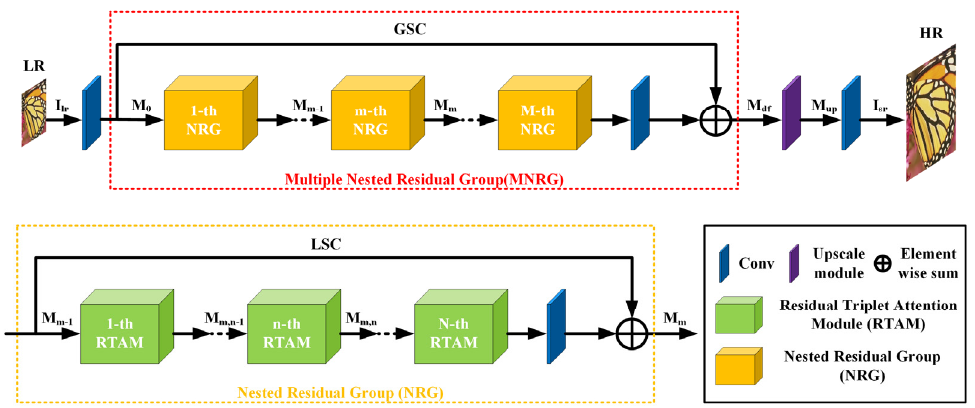
Figure 1. The overall architecture of the residual triplet attention network (RTAN). A 3 × 3 convolutional layer of 64 filters is applied to extract the shallow features from the LR input.